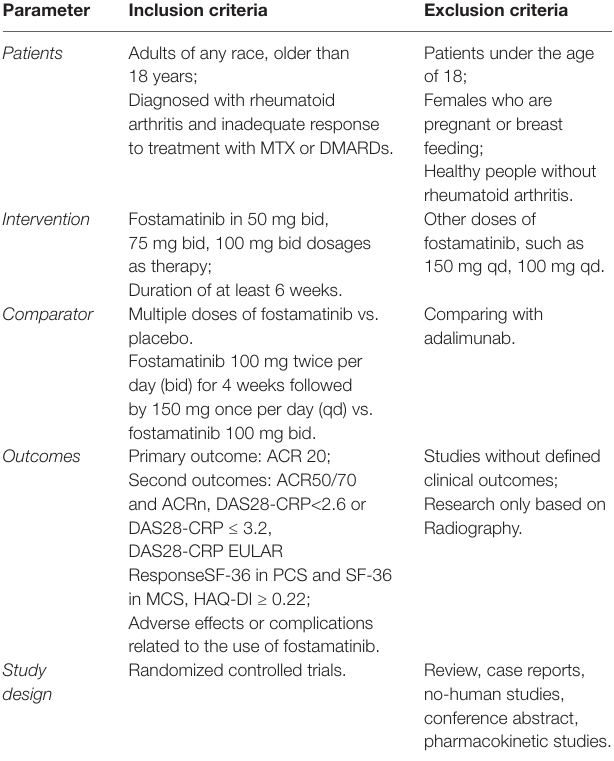
TABLE 1 | PICOS criteria for inclusion and exclusion of